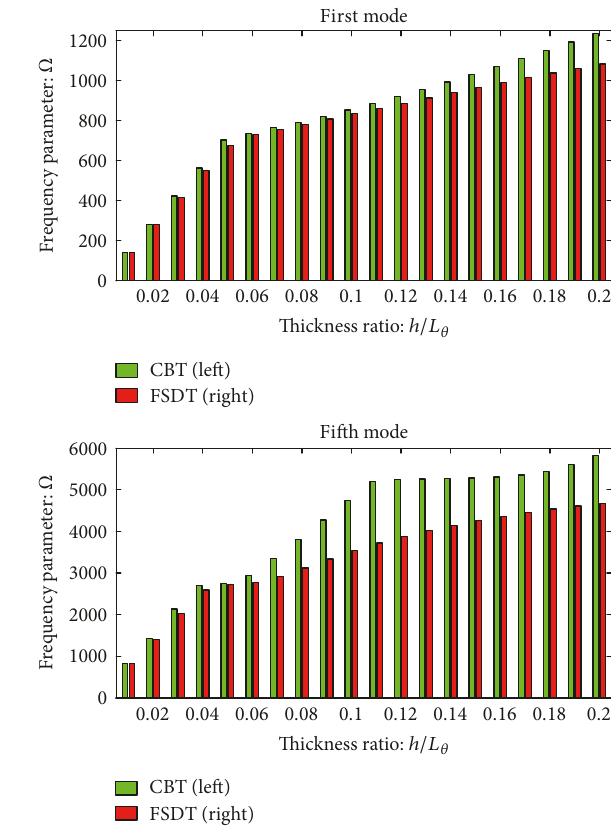
Figure 7: Frequency parameters Ω of circular beams with various thickness ratios based on the CBT and FSDT theory models (C-C boundary